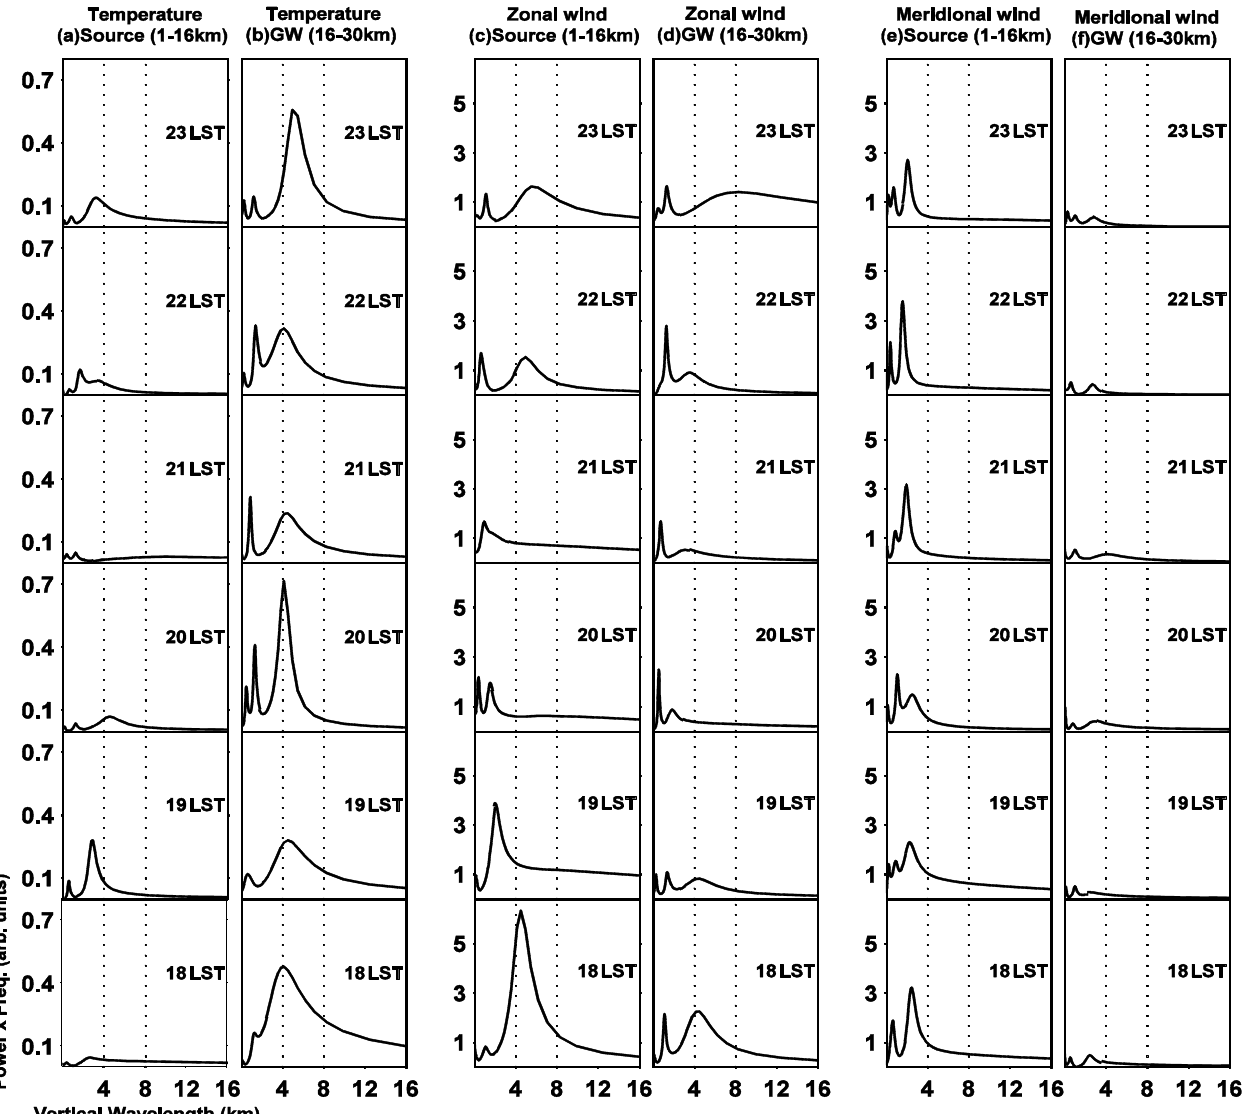
Fig. 10. Temporal distribution of Vertical wavelength ( λ Z ) for temperature (panels a , b ), zonal wind (panels c , d ) and meridional wind (panels e , f ) on 30 November 2005. Panels (a) , (c) , and (d) denote source power spectra (1–16km heights), while panels (b) , (d) , and (f) denote GW spectra as they are computed between 16 and 30km height range. Source spectra were multiplied by a factor of “3” to increase the power for comparison with GW. The panels are arranged columnwise. Vertical lines drawn on x-axis denote vertical wavelength at 4km and 8km, respectively. Y-axis represents power (in arbitrary units) in all panels.